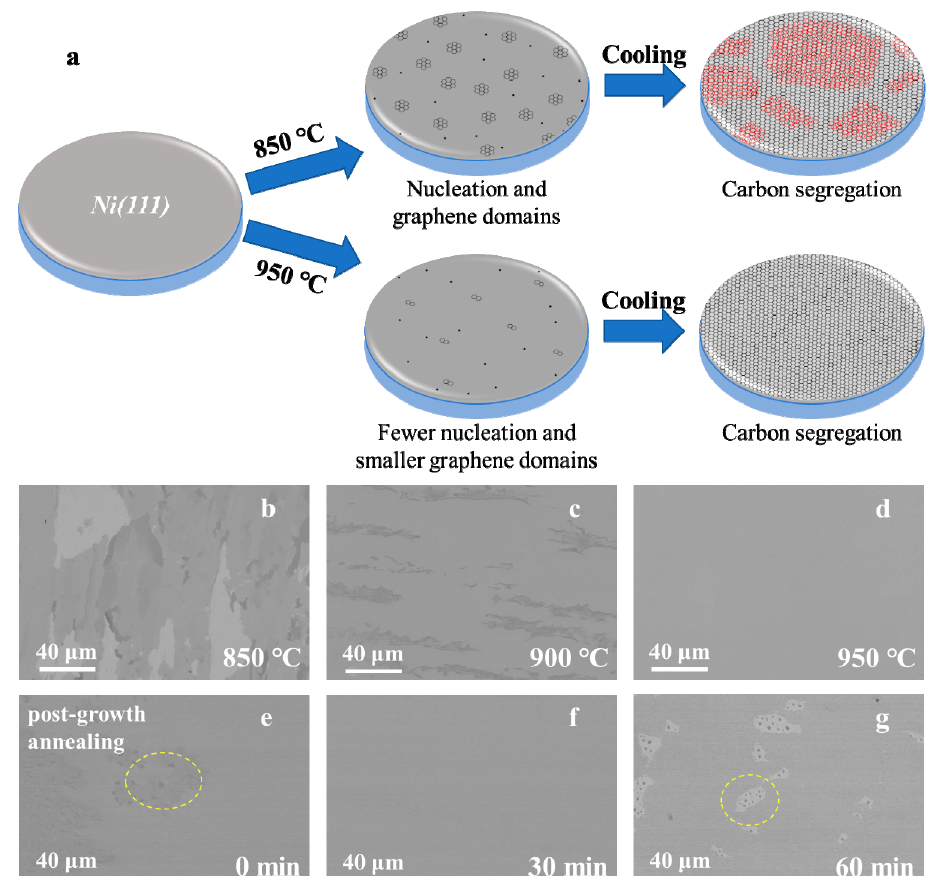
Figure 3. Regulating the growth process of graphene for single-crystal monolayer graphene. ( a ) Schematics for the fabrication of graphene on Ni (111) film at two topical temperatures, 850 and 950 °C, respectively. ( b – d ) Typical SEM images of graphene grown on Ni (111) film at 850, 900 and 950 °C, respectively. ( e – g ) Typical SEM images of graphene grown on Ni (111) film under different post-growth annealing times at 950 °C.